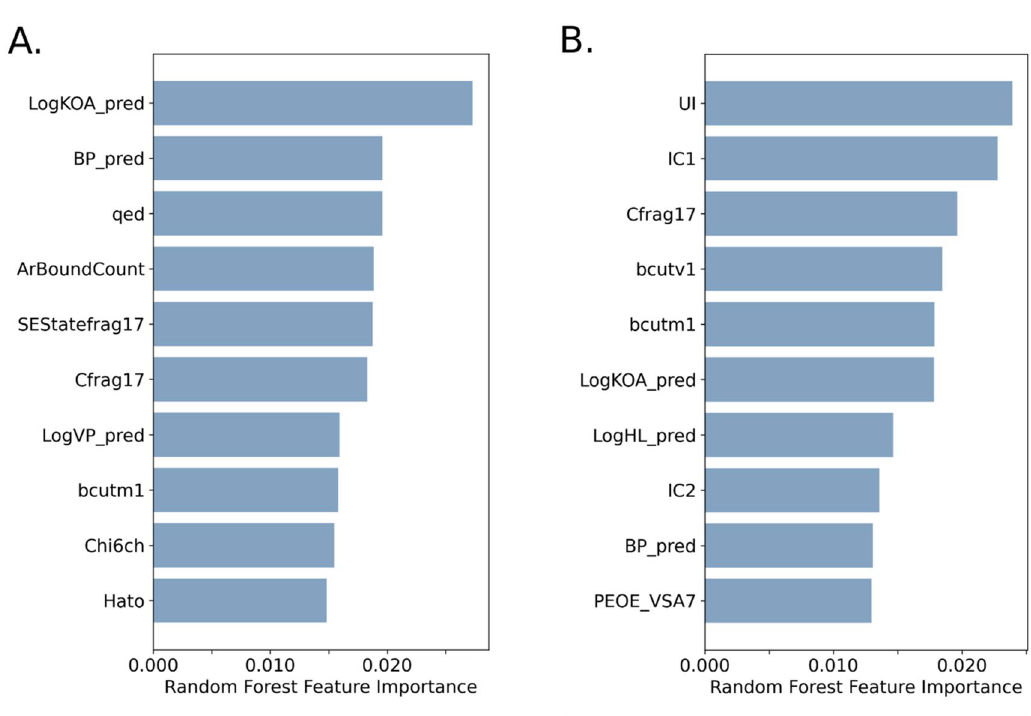
Figure 9. Top 10 of descriptor importance, in relative value, of features for balanced RF developed for ( A ) E2up and ( B ) P4up QSAR